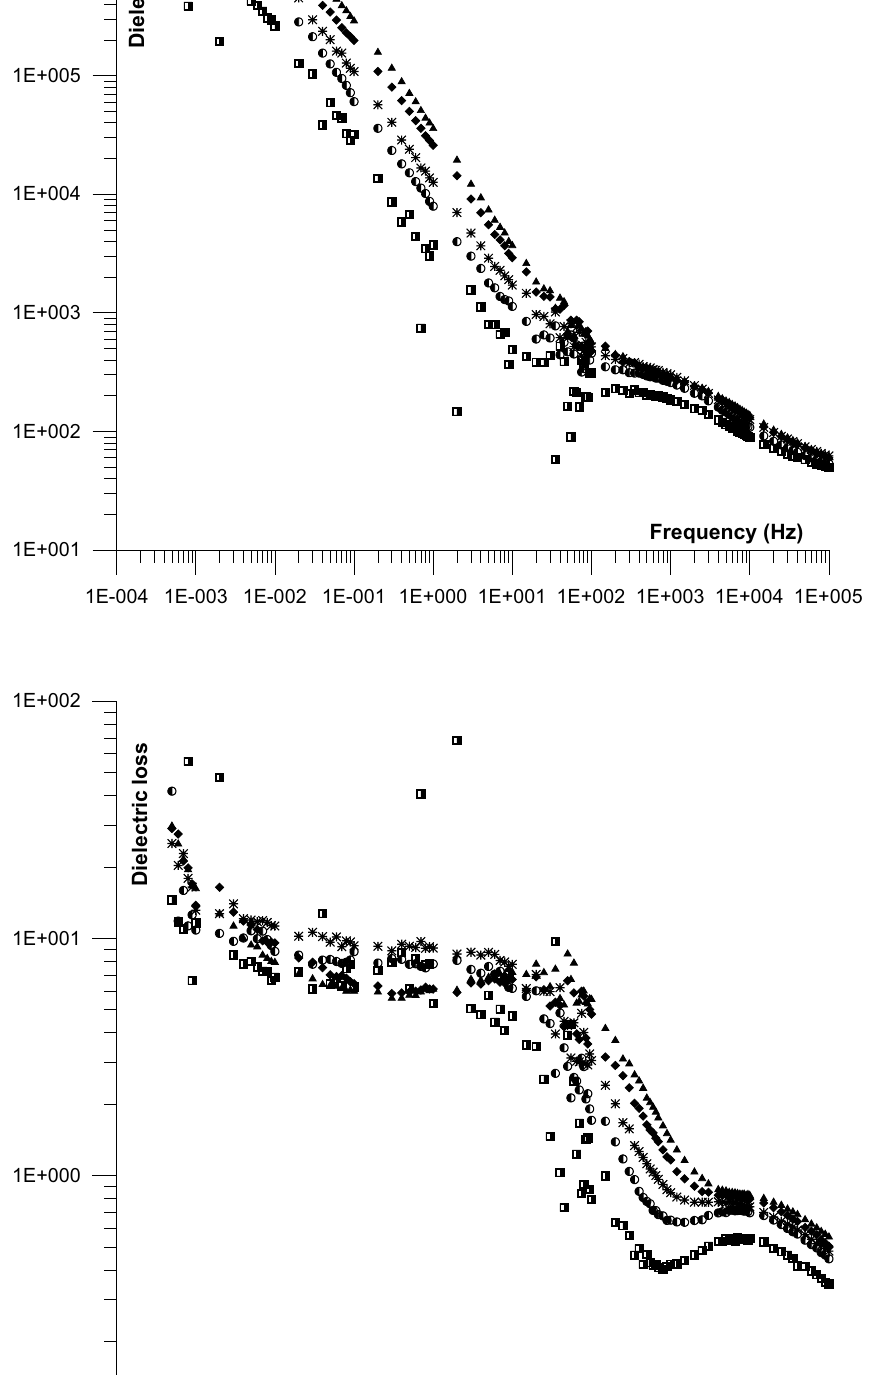
Fig. 3 Variation of the real part of the dielectric constant with frequency for Aswan iron ore deposits, for samples 1 ( ) , 2 ( ) , 3 ( ) , 4 ( ) and 5 ( ) , respectively